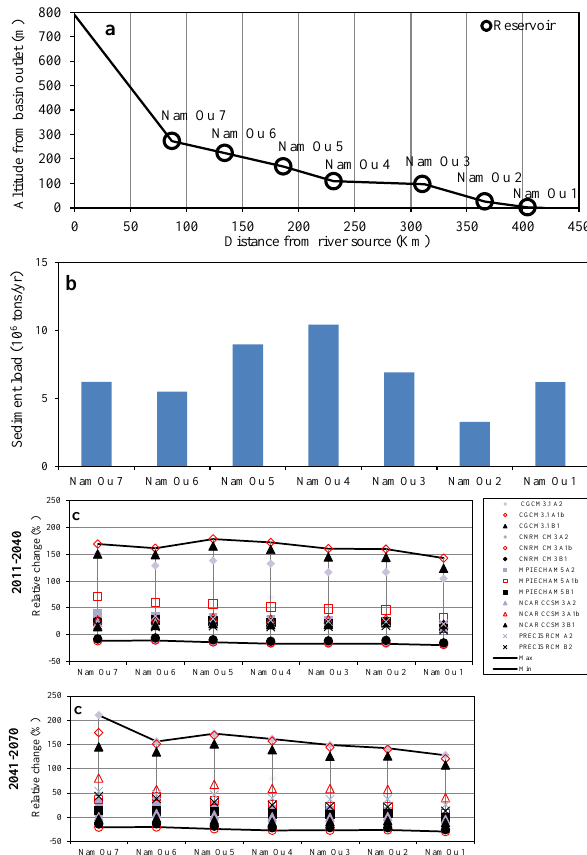
Fig. 15. (a) Longitudinal profile of the main stream showing the locations of planned reservoirs, and their elevation relative to the basin outlet datum. (b) Averages of simulated annual sediment load (1971–2000) at planned reservoir stations and (c) relative changes in future sediment yield as compared to 1971–2000 for all climate projections. Results are for the 2011–2040 and 2041–2070 time pe-